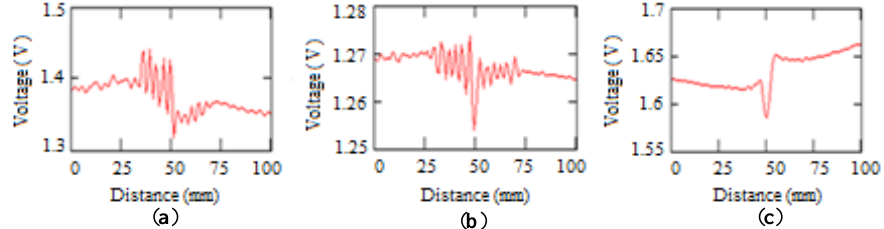
Figure 6. Signals recorded under 50 × 70 scanning, obtained at three standoff distances: ( a ) 0.2 mm, ( b ) 0.8 mm, and ( c ) 1.7 mm.